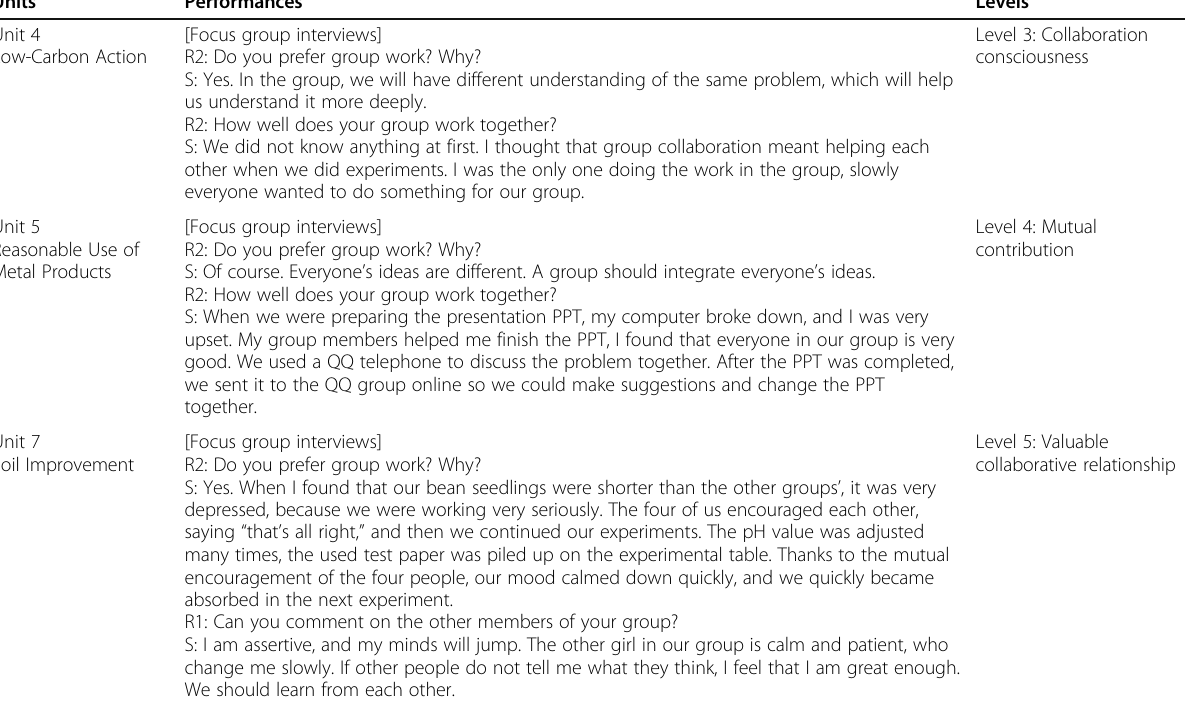
Table 8 Students ’ performances in collaboration